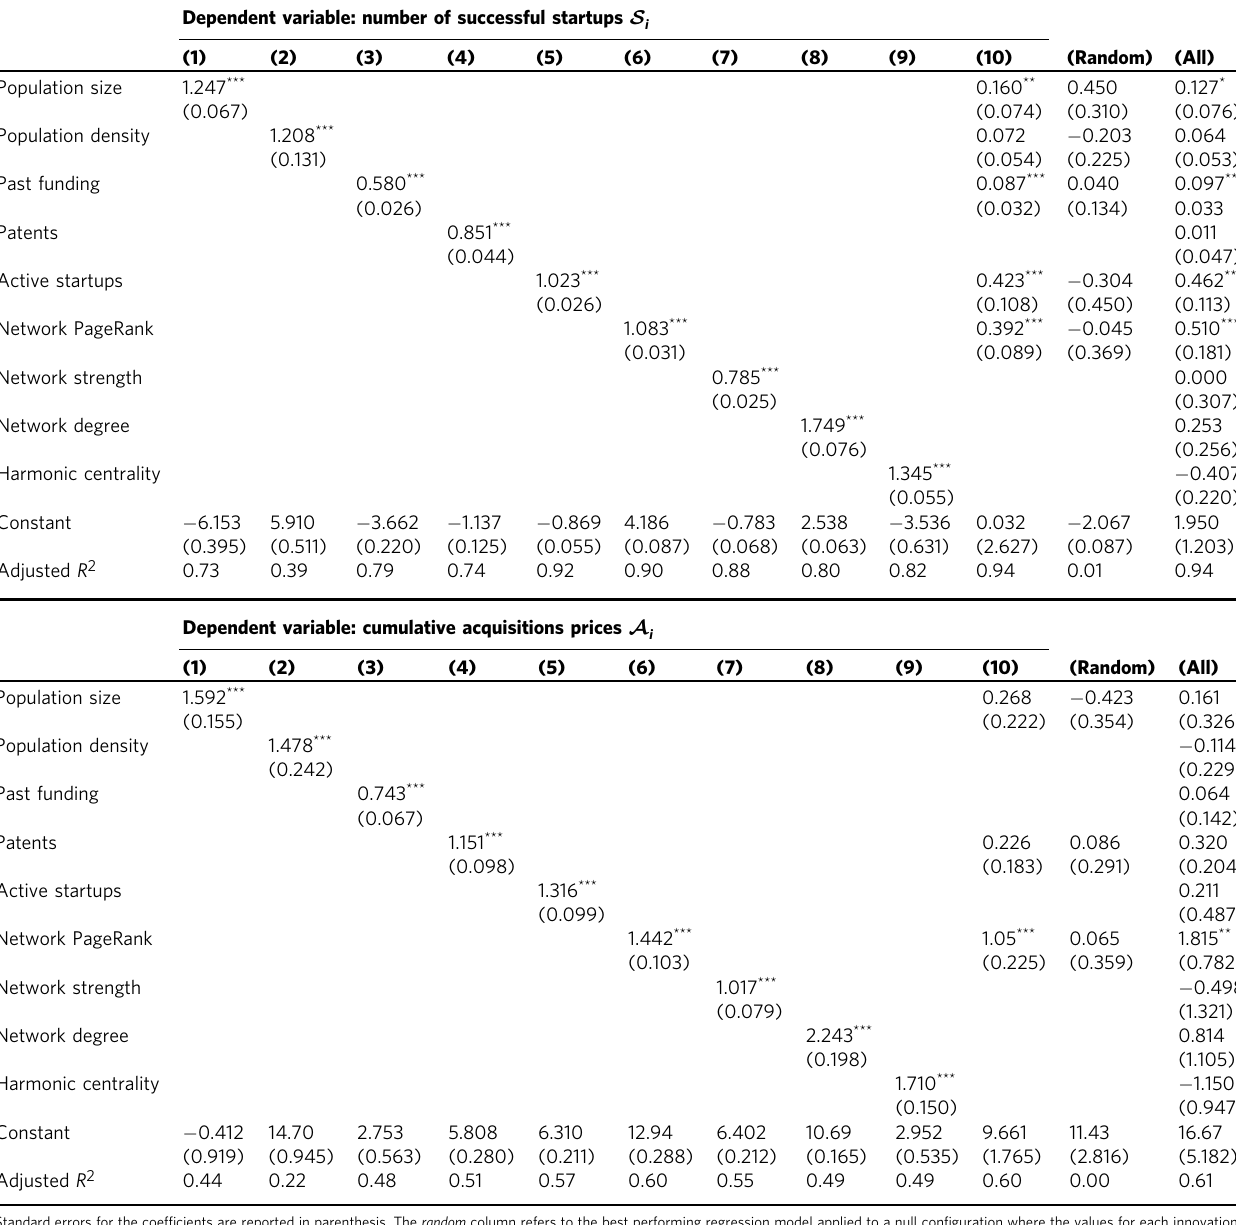
Table 2 β -coef fi cients of the regression models to predict the two dependent variables of innovation performance, namely the number of successful startups S i and the cumulative acquisition price A i